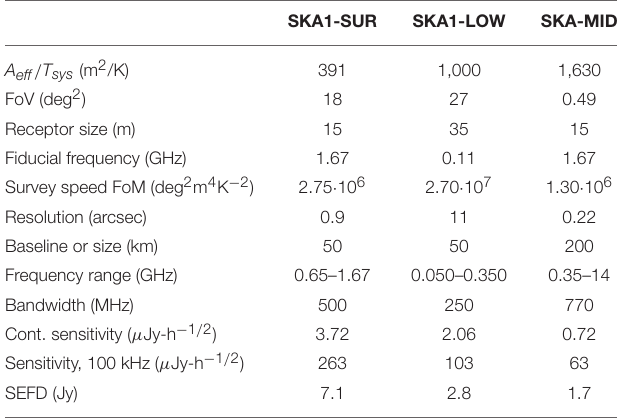
TABLE 2 | Parameters for SKA, according to Dewdney et al. (2013); see https:// www.skatelescope.org/wp-content/uploads/2012/07/SKA-TEL-SKO-DD-001-